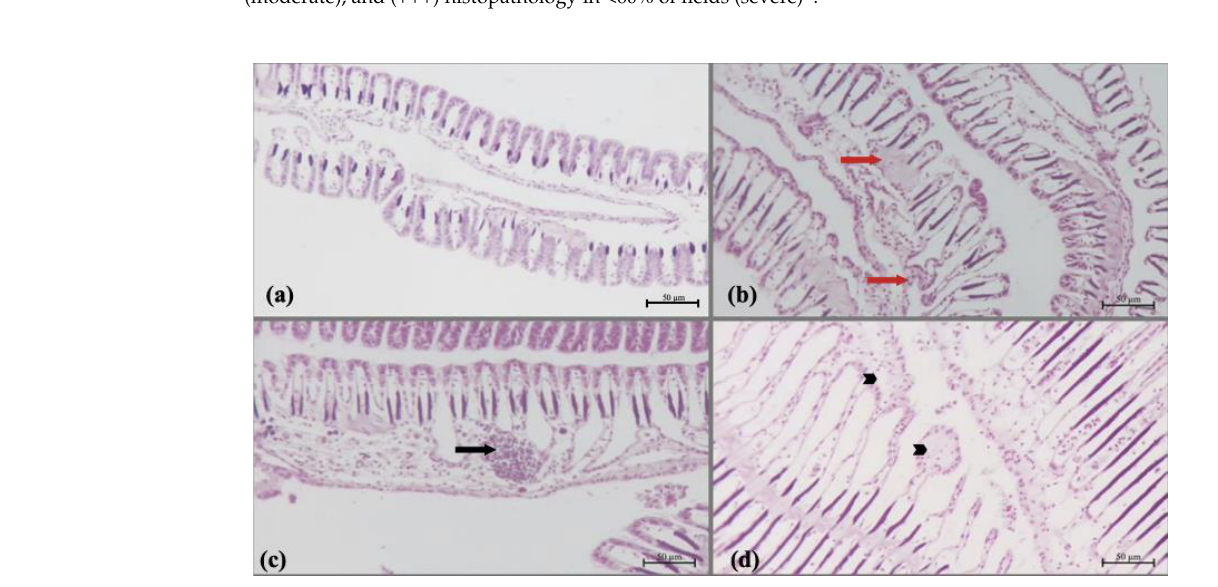
Figure 7. Digestive gland tissue of the freshwater mussel, Unio delicatus ( a ) control, ( b ) deformation of the tubules (red arrows) after exposure to 0.264 mg/L fipronil for 48-h, ( c ) necrosis of the digestive tubules (black arrows) after exposure to 0.528 mg/L fipronil for 7-d ( d ) deformation of the tubules after exposure to 0.524 mg/L fipronil for 7-d (black arrow heads) (H&E). As filter -feeding organisms in the food web, mussels can easily accumulate water- borne toxicants from water bodies and reflect changes in water quality. Gills and the di- gestive gland tissues are the organs most affected by xenobiotics in the mussels [28,74]. Exposure to fipronil after 48 h and 7 d resulted in alterations in the gill tissues such as degeneration, haemolymph infiltration, and epithelial hyperplasia in the lamella, and tu- bule degenerations and necrosis in the digestive gland tissues in the present study. No study was found related to fipronil toxicity and its histological effects on mussels in the literature survey, but some studies on fish species were reported. Ardeshir et al. [75] de- termined aneuri sms, extensive fusion, and necrosis in the gill tissues of white fish ( Rutilus frisii ) and El-Murr et al. [76] noticed focal necrosis, intense lymphocytes, epithelial prolif- erations, fusion, hyperplasia of epithelium, congestion, and haemorrhages in tilapia ( Ore- ochromis niloticus ) after exposure to 0.0042 and 0.002 mg/L fipronil for 10 weeks. Ghaffar et al. [77] studied common carp exposed to 0.02 –0.10 mg/L fipronil for 12 -d and observed